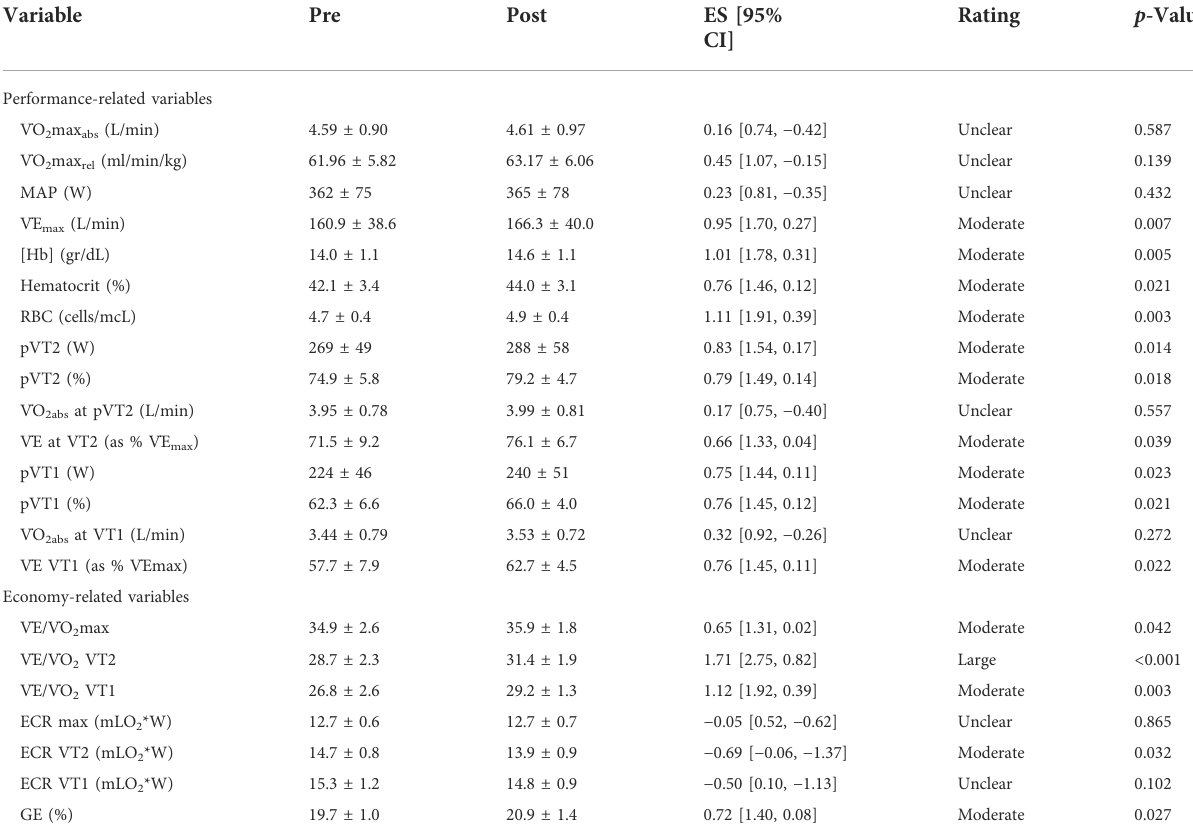
TABLE 2 Effects of a 3-week moderate altitude training camp on performance and economy/ef fi ciency-related variables. Variable Pre Post